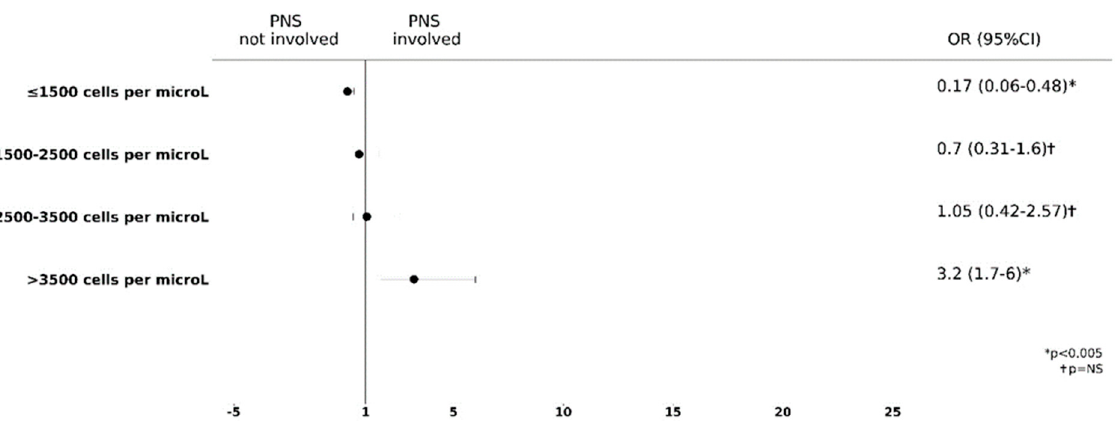
Figure 3. Prediction of PNS involvement using blood eosinophil count as a predictor (Logistic Regression).